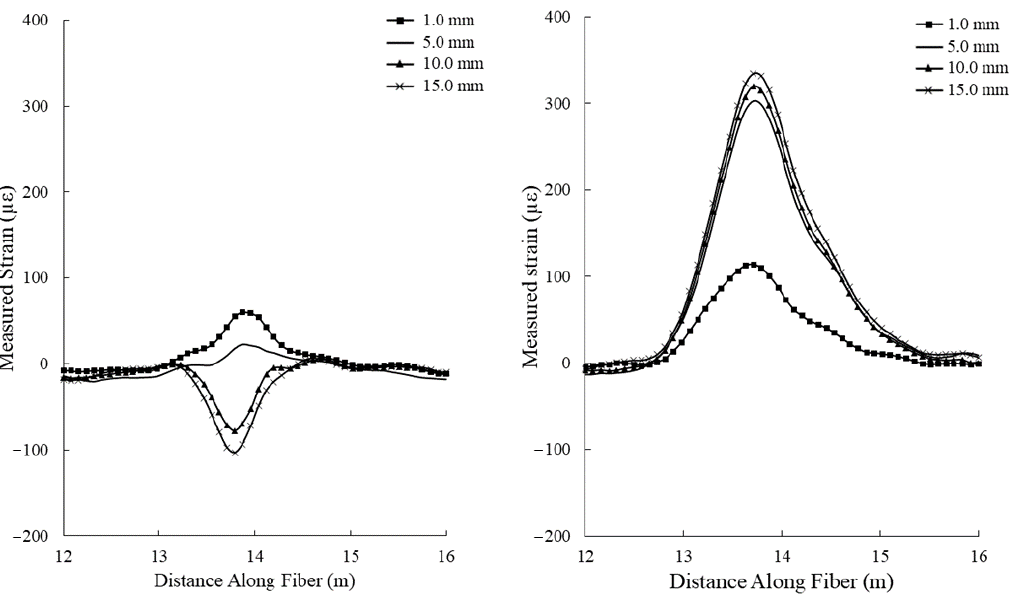
Figure 17. Strain measurements taken for incremental displacement (from 1.0 to 15.0 mm) values during the large tensile deformation experiment using a standard fiber optic cable ( left ) and the hybrid fiber optic cable ( right ). Note that the standard fiber optic cable shows a decreasing strain value at higher displacements, indicating a slippage of the optical fiber within the jacket material.